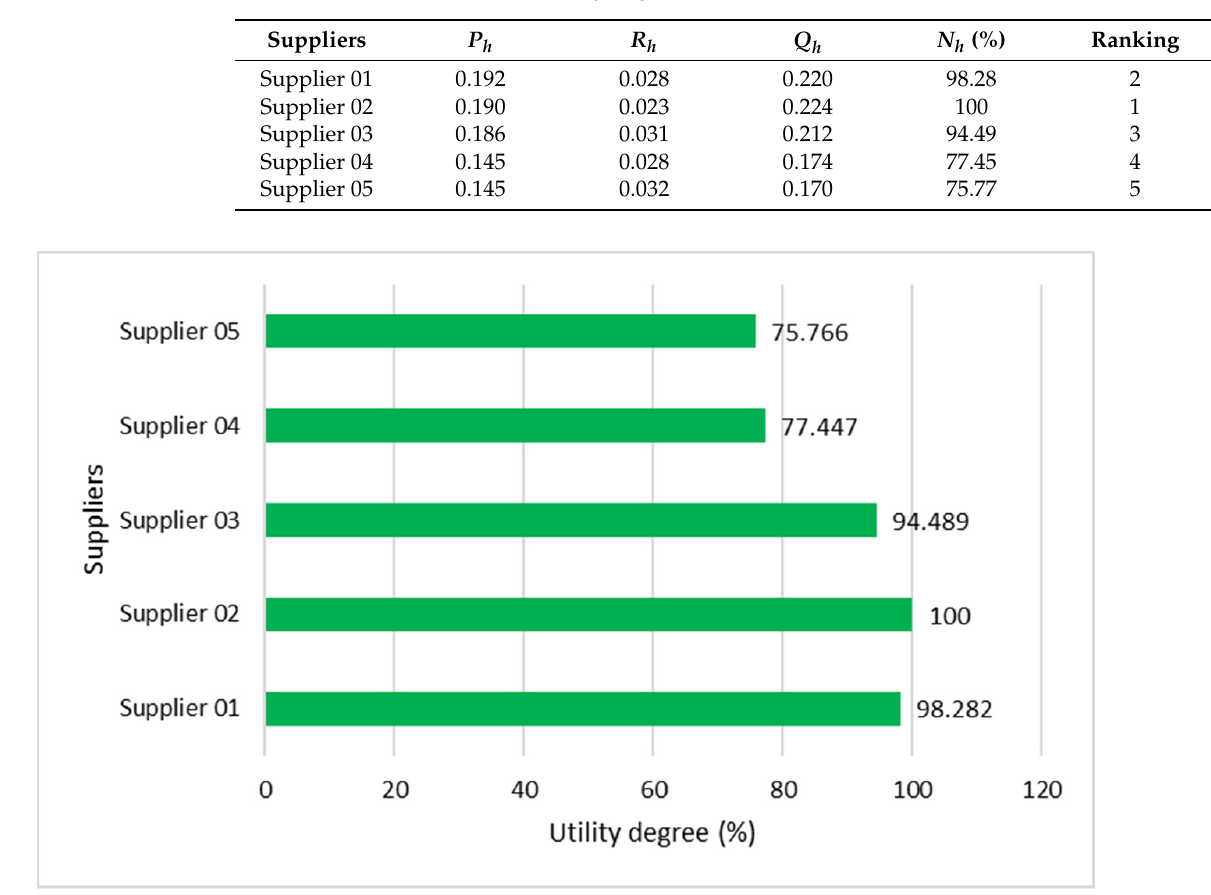
Figure 4. Final ranking of suppliers.